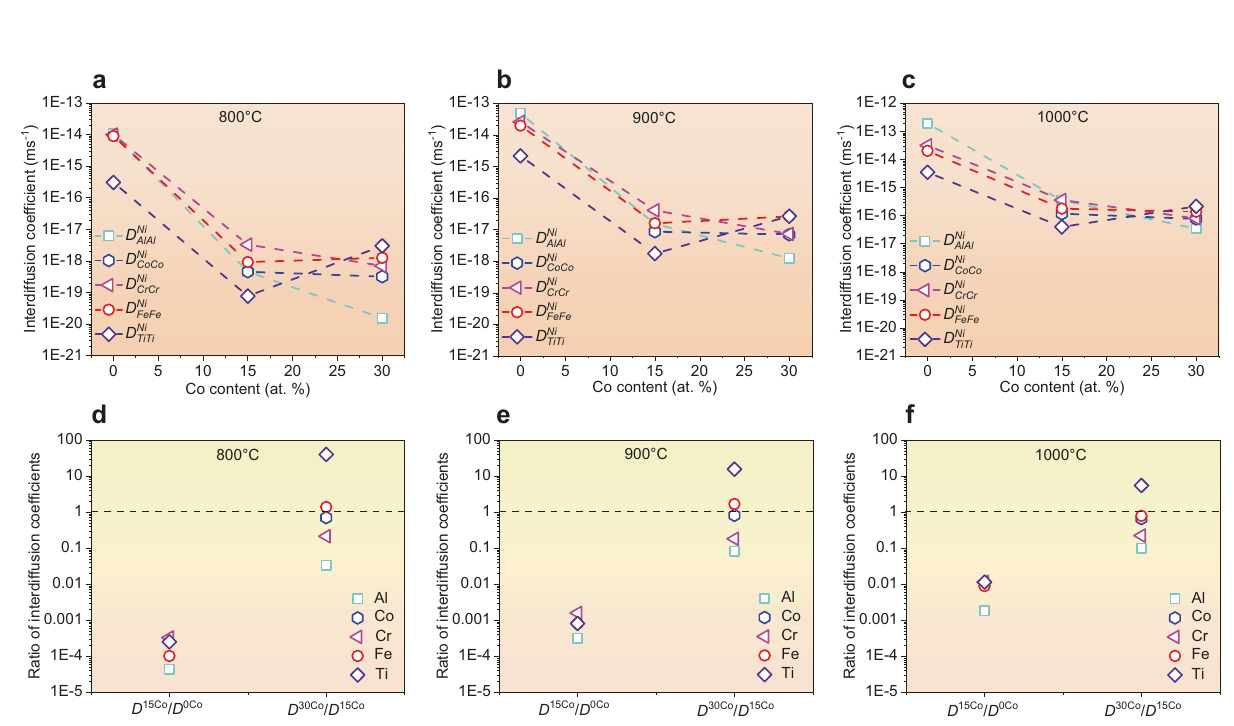
Fig. 3 | Coarsening kinetics and associated mechanisms of L1 2 precipitates in the0Coand15CoCCAs.a , b Plotsof r 2 vs. t ofL1 2 precipitatesinthe0Coand15Co CCAs aged at 800, 900, and 1000°C. c , d Arrhenius plot of the coarsening rate constant (ln(k×T)) as a function of the reciprocal aging temperature (1/T) deter- mines the activation energy ( Q ) for the 0Co and 15Co CCAs based on the TIDC